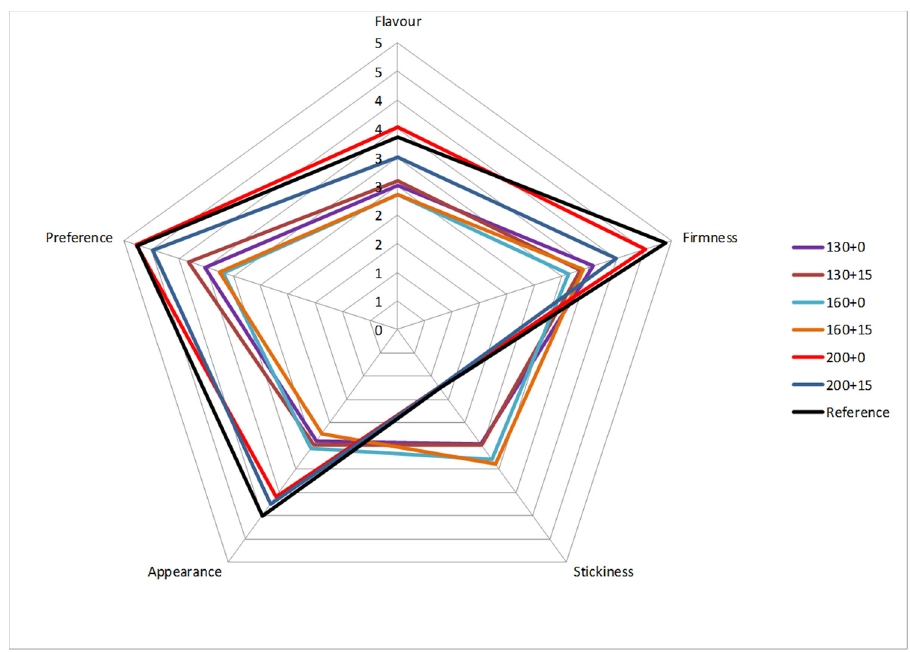
Figure 3. Sensory properties ( n = 15) of pasta from site-specific harvest of cv. Biensur compared with those of the commercial reference cv. Aureo . The different fertilization managements listed in the legend are reported in Table 1.